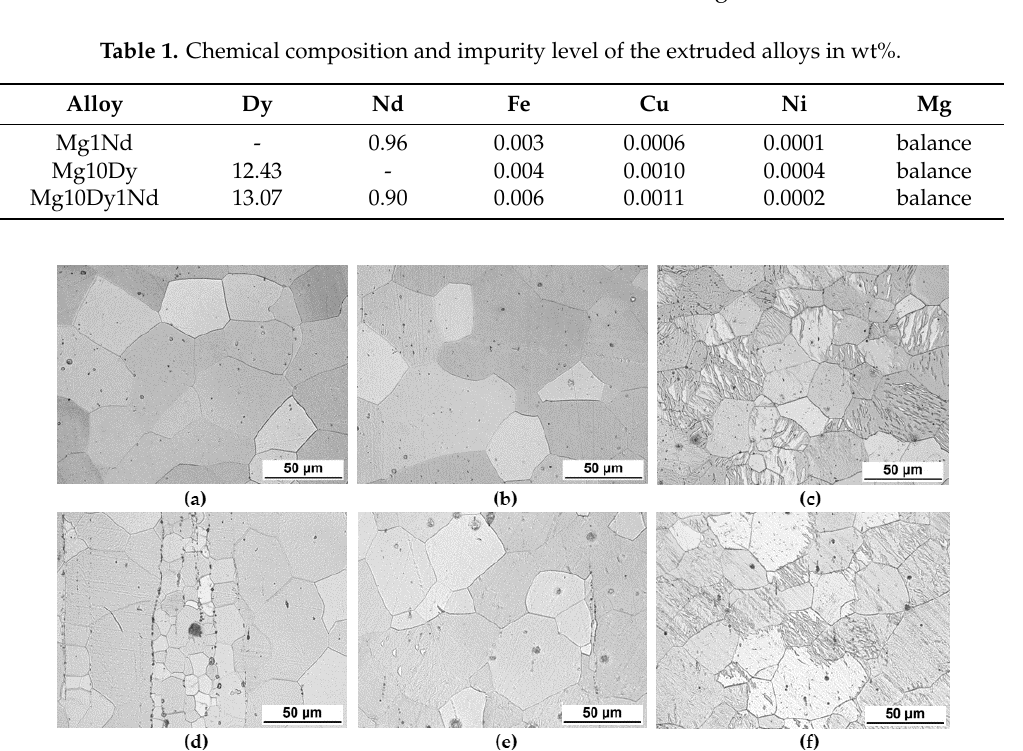
Figure 2. Optical micrographs of the Mg10Dy1Nd ( a , d ), Mg10Dy ( b , e ) and Mg1Nd ( c , f ) alloys. Transverse ( a – c ) and longitudinal cross sections, where the extrusion direction was vertical ( d – f ).